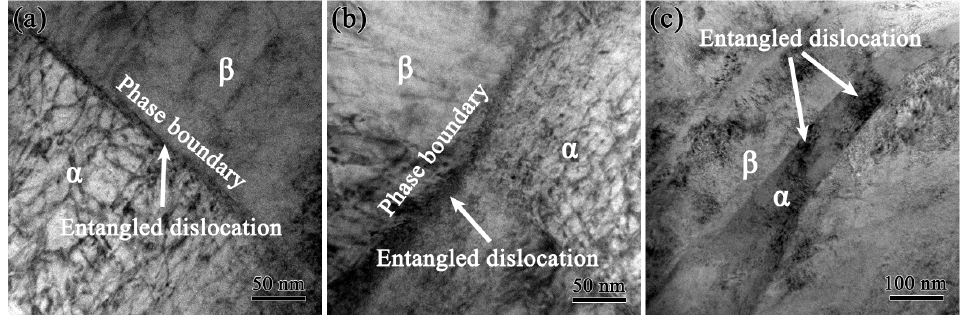
Figure 11. TEM images of the TC4 welded joint after ( a ) 10,000, ( b ) 20,000, and ( c ) 30,000 cycles.